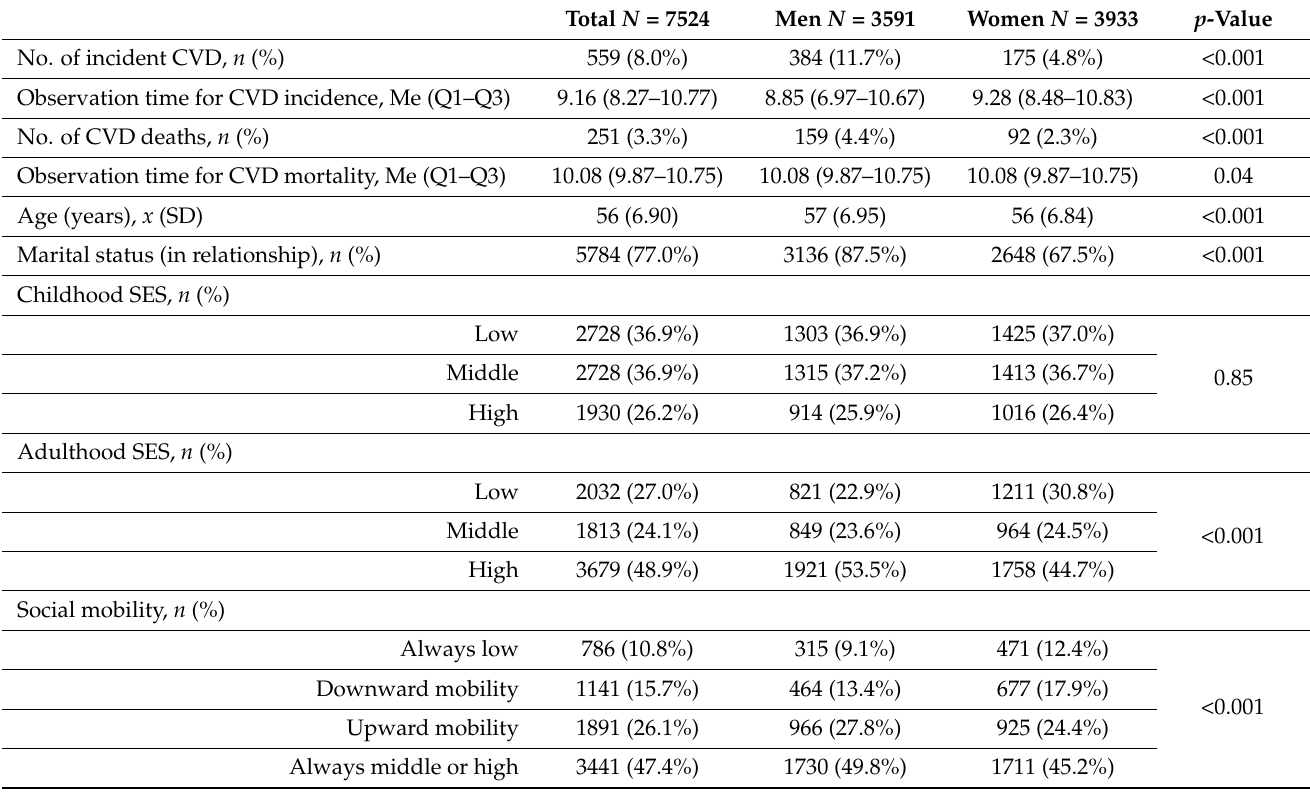
Table 1. Descriptive statistics of the study group by